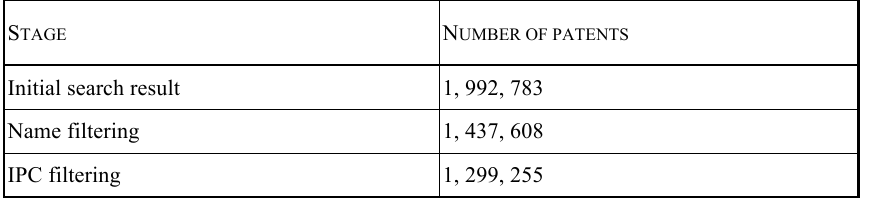
Table 1 . Number of patents in different stages of research process. S TAGE N UMBER OF PATENTS Initial search result 1, 992, 783 Name filtering 1, 437, 608 1, 299,